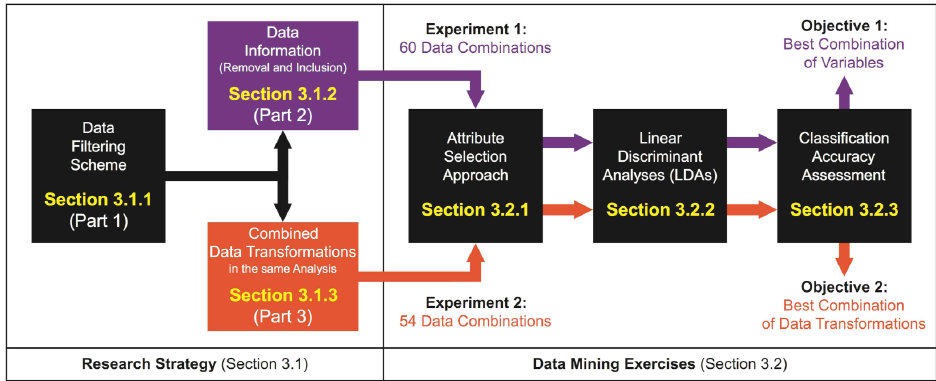
Figure 2. Methodological steps: research strategy and data mining exercises. Experiment 1 and Experiment 2 are aligned with our